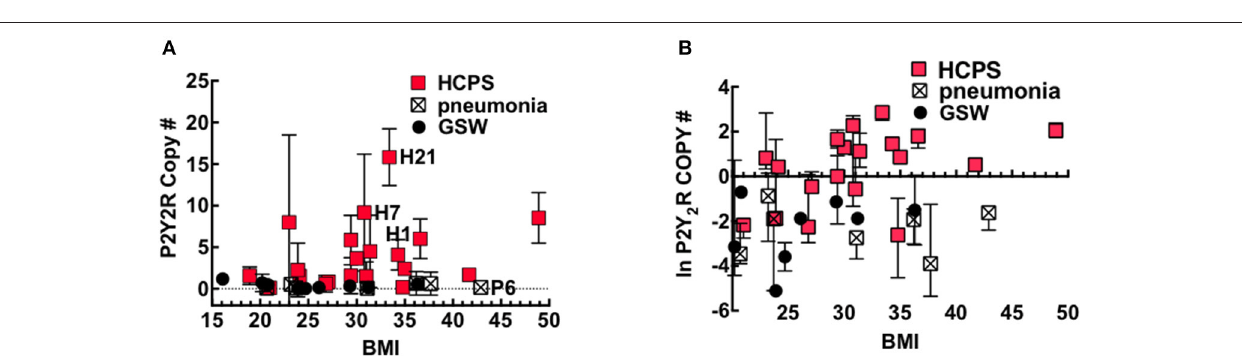
FIGURE 4 | P2Y 2 R expression is significantly upregulated in HCPS compared to controls. Plots of (A) Mean and (B) Natural log-transformed values of P2Y 2 R copy numbers in 10 µ m slices cut from the FFPE lung tissue blocks versus body mass index or BMI of Gunshot, pneumonia and HCPS cases. Error bars represent measurements of P2Y 2 R in slices from different segments of lung tissue from each case (indicated in Figure 3 ). Statistical analysis was performed on natural log-transformed data to approximate a normal distribution. See text for details.